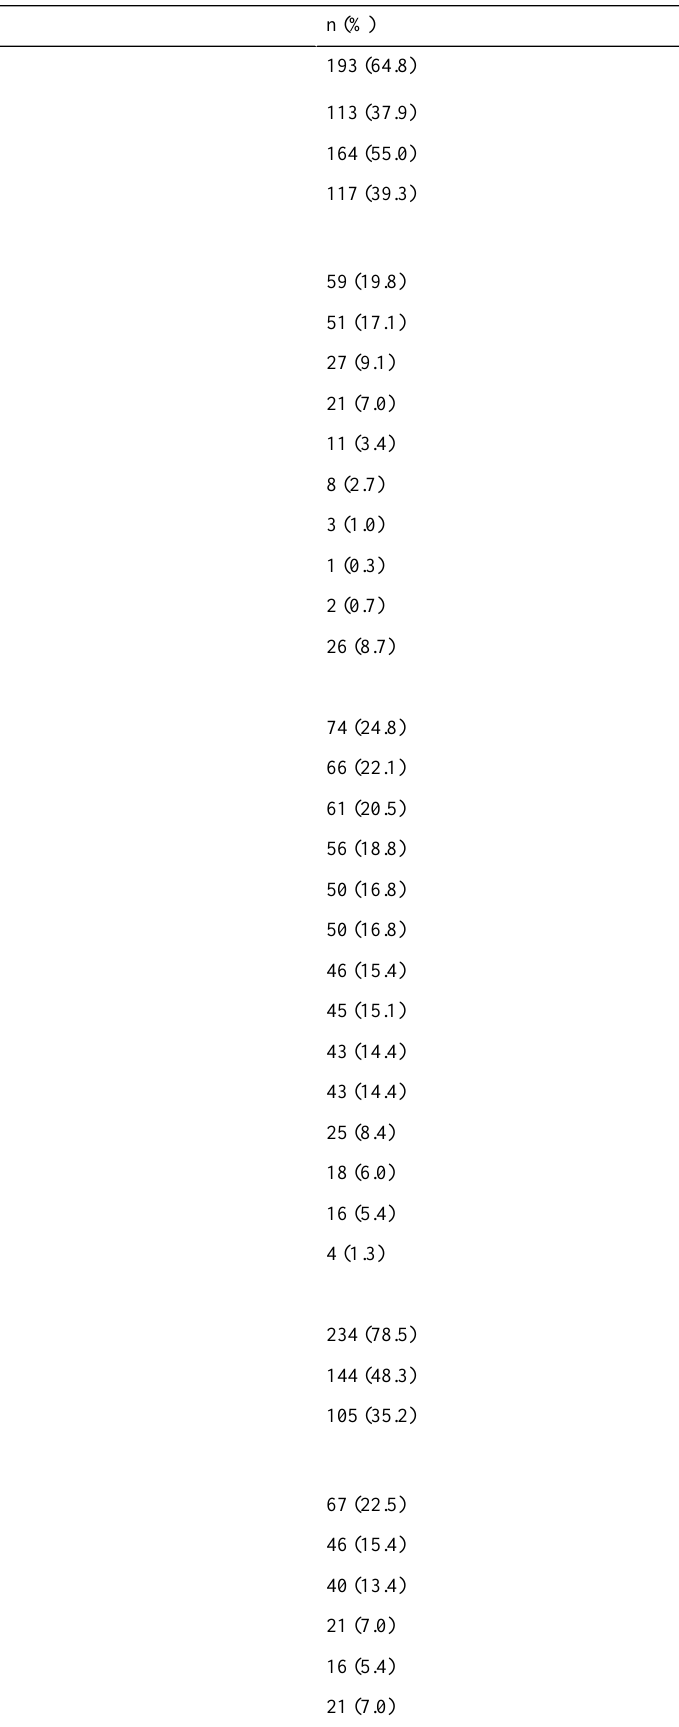
Table 4. Computer, internet, and email